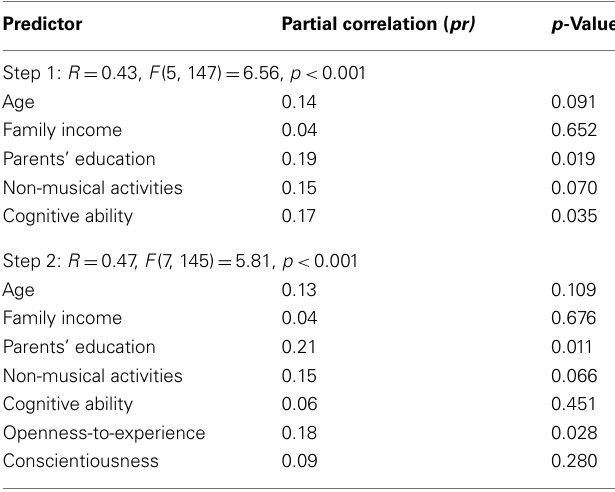
Table 4 | Results from hierarchical multiple regression in study 2 (children).